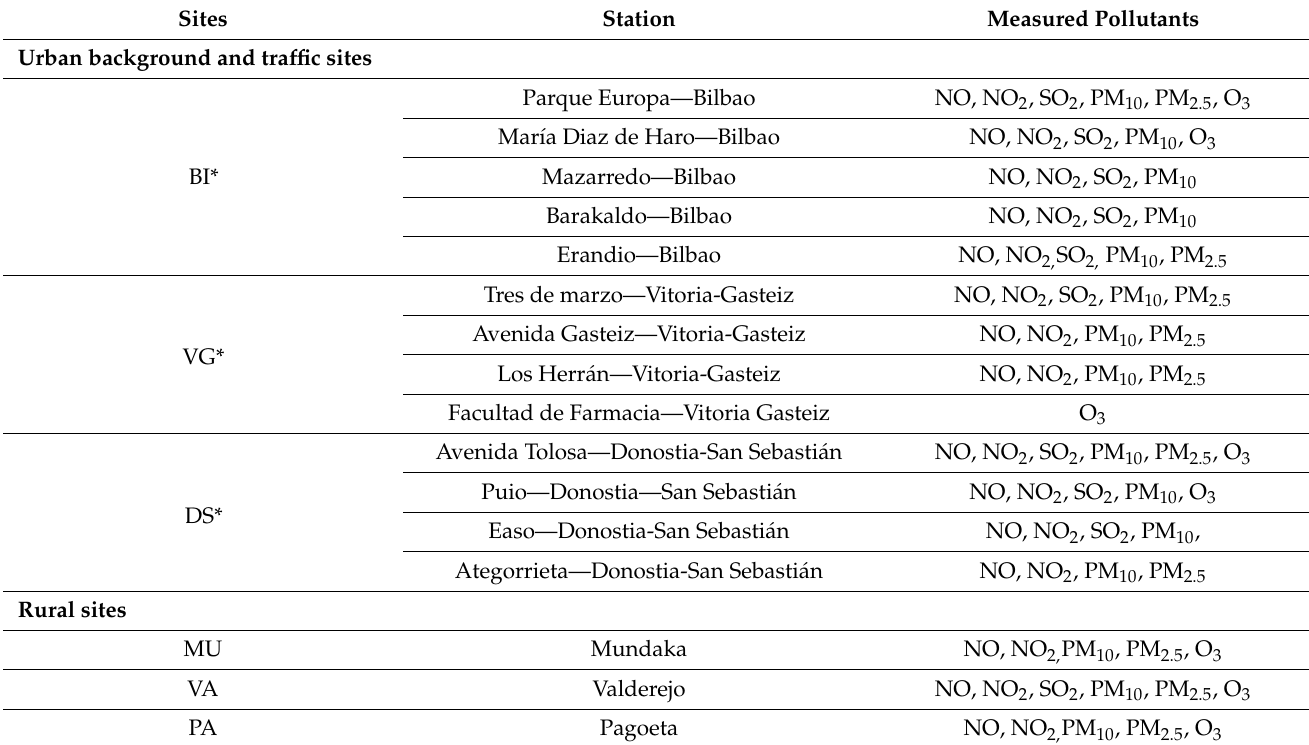
Table 1. Selected urban background, traffic and rural sites, corresponding stations, and measured pollutants. Clustered urban background and traffic sites are marked with an asterisk *. Sites Station Measured